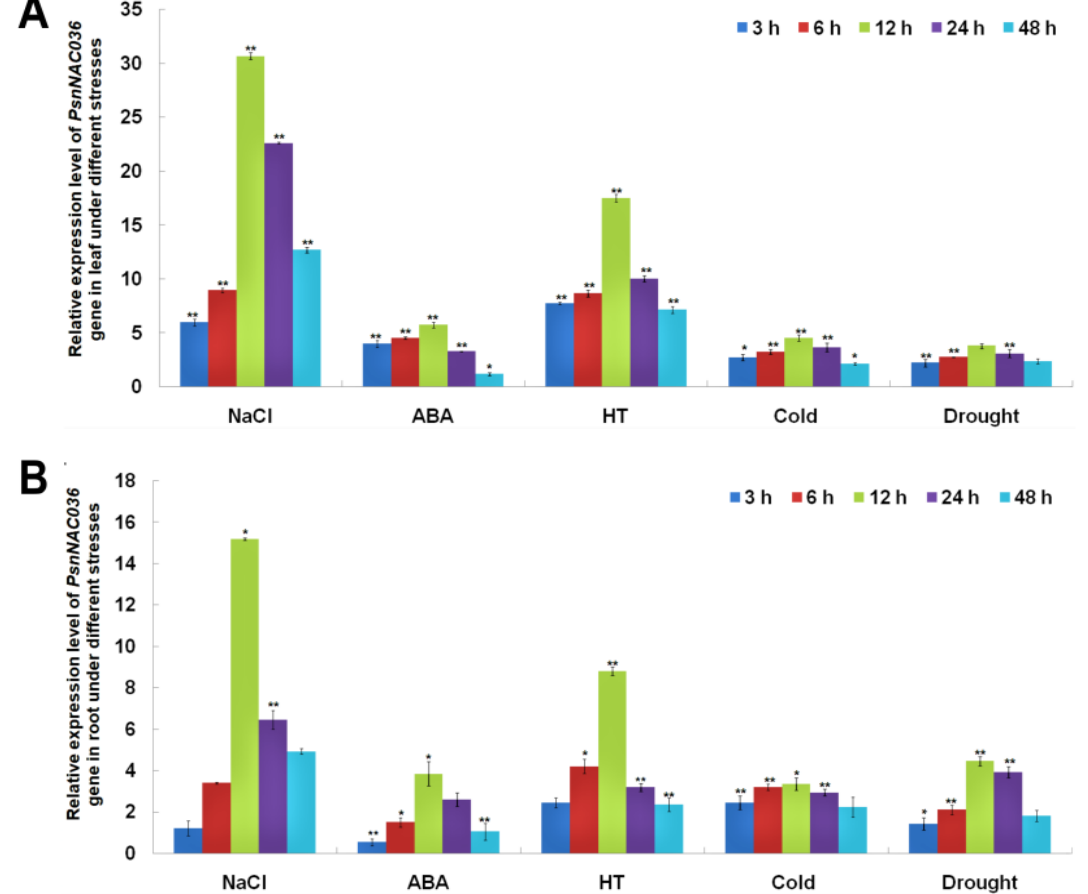
Figure 2. Expression analysis of the PsnNAC036 under various treatments. Relative expression levels of PsnNAC036 in leaves ( A ) and roots ( B ) after NaCl (150 mM), ABA (50 µ M), high temperature (HT, 37 ◦ C), cold (4 ◦ C), or drought treatments. Expression levels in the control samples were normalized to 1. The data are from three independent experiments. Student’s t -test: t : * p < 0.05; ** p < 0.01. Error bars indicate mean ± standard deviation.